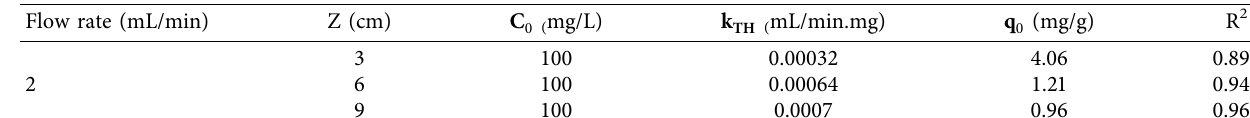
Figure 9: Thomas model plot for copper removal at different bed depths. (a) Bed depth of 3cm. (b) Bed depth of 6cm. (c) Bed depth of 9cm. Table 8: Thomas model parameters for copper